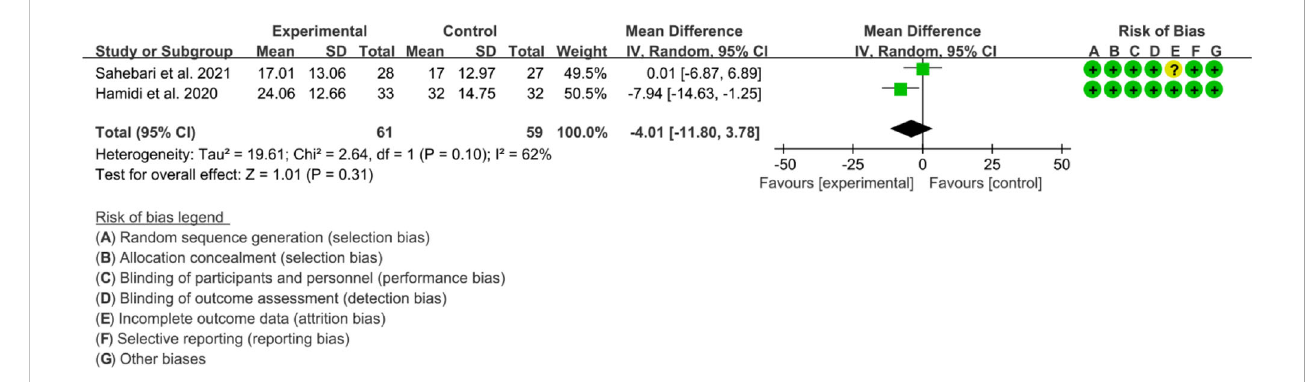
FIGURE 9 ESR in Crocus sativus